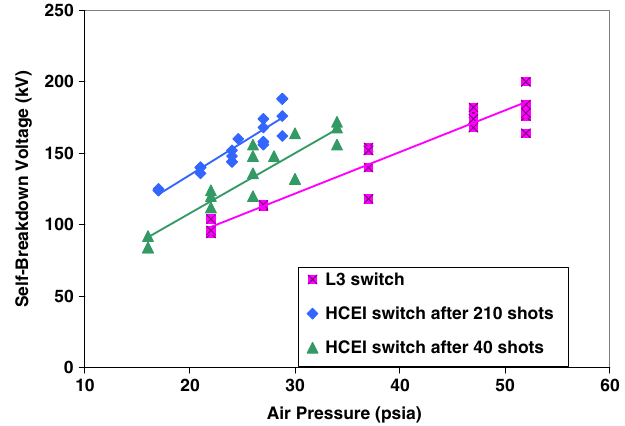
FIG. 11. (Color) Self-breakdown voltages of the Russian and L3 switch as a function of dry air pressure.